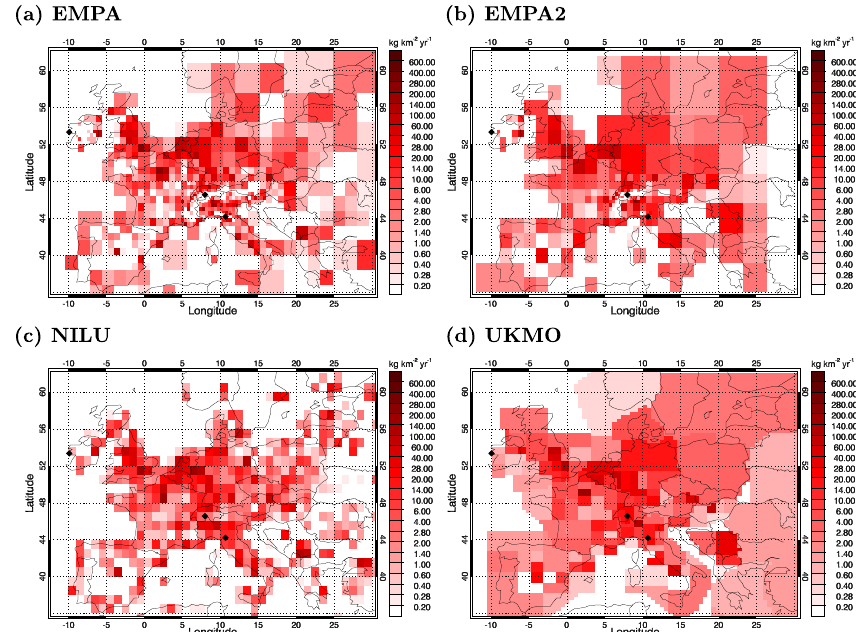
Figure 5. Prior emissions of HFC-134a as represented in the four inversion systems.